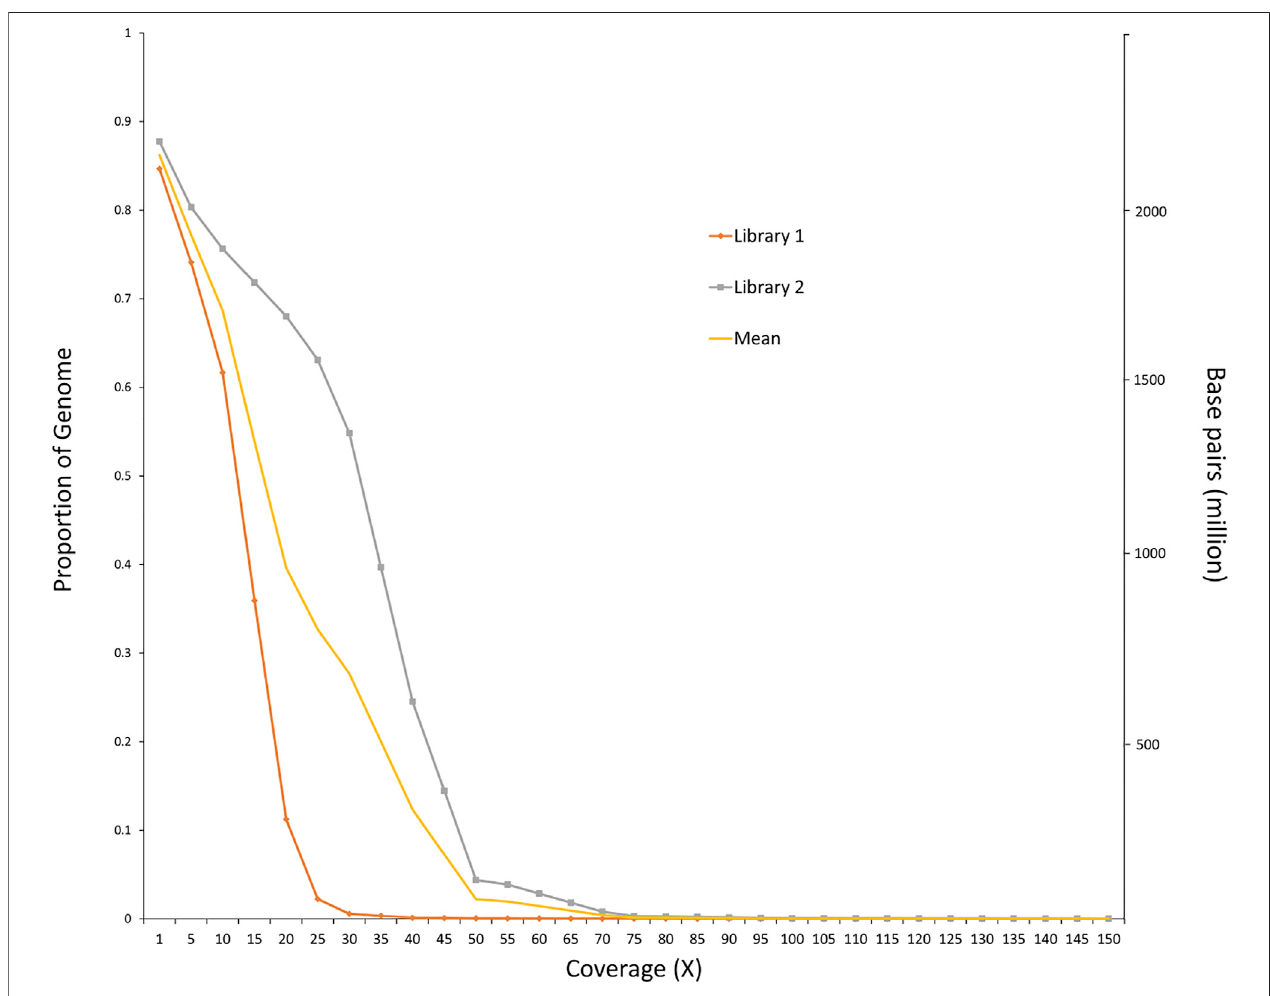
FIGURE 3 | Proportion of genome covered at different sequence read depths. The orange line represents Library 1, which consists of 39 anadromous males. The gray line represents library 2, which consists of 78 resident males.